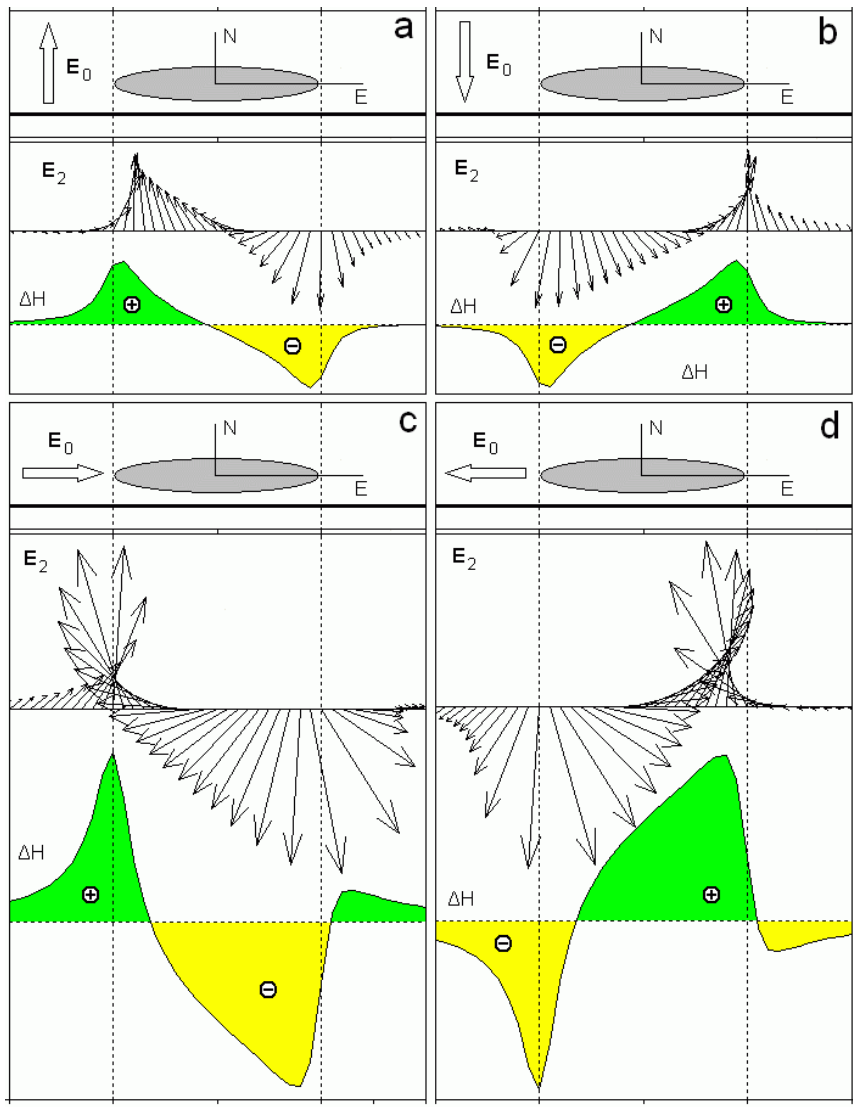
Fig. 9. Results of calculation of the polarization electric field in the ionosphere (arrows) and associated magnetic disturbance (highlighted curves) on the ground. Sketches show four uttermost variants of orientation of the irregularity (gray ellipse) relatively background electric field (open arrow), which my be realized under different B z orientation and at different